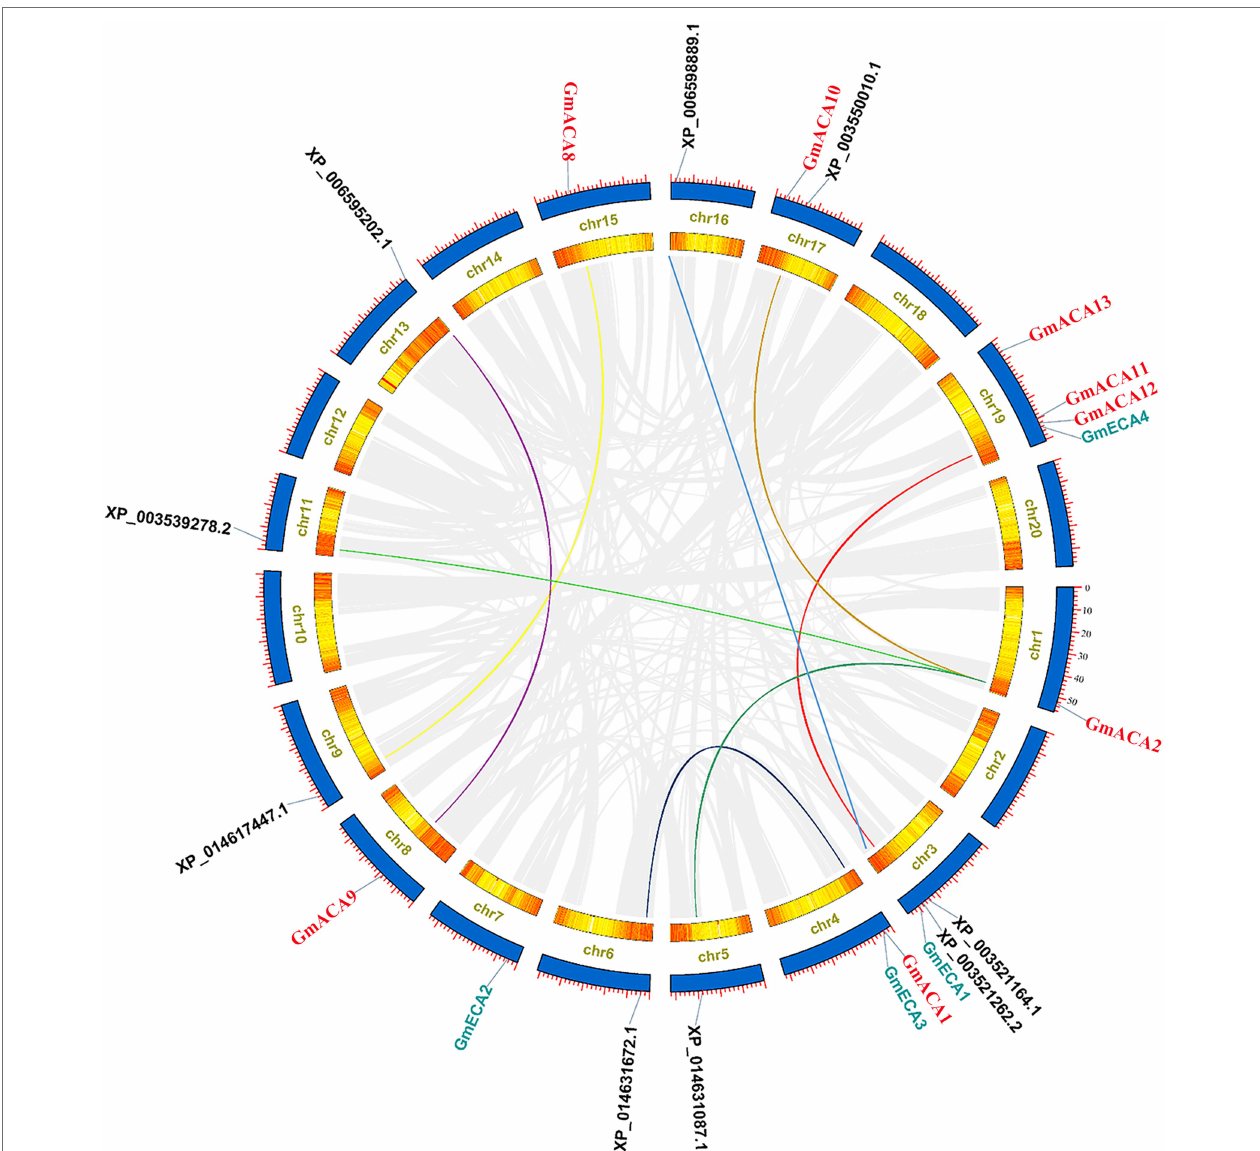
FIGURE 3 | Chromosome localization and collinearity analysis of Glycine max P 2 -type ATPases family proteins. Colored lines indicate P 2 -type ATPases syntenic blocks in the soybean genome. Gray lines indicate all syntenic blocks except P 2 -type ATPases. The shades of color in the inner chromosome chromosomes represent the number of genes at the location of the chromosome, and yellow to red indicates the number of genes from low to